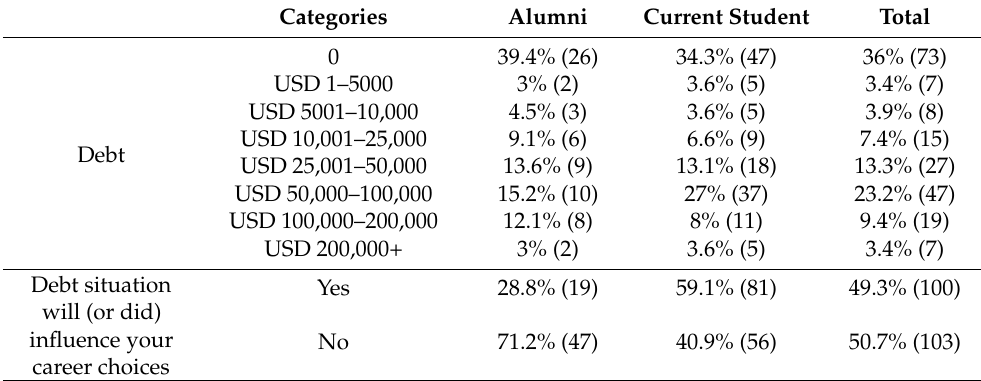
Table 3. DrPH finance outcomes and